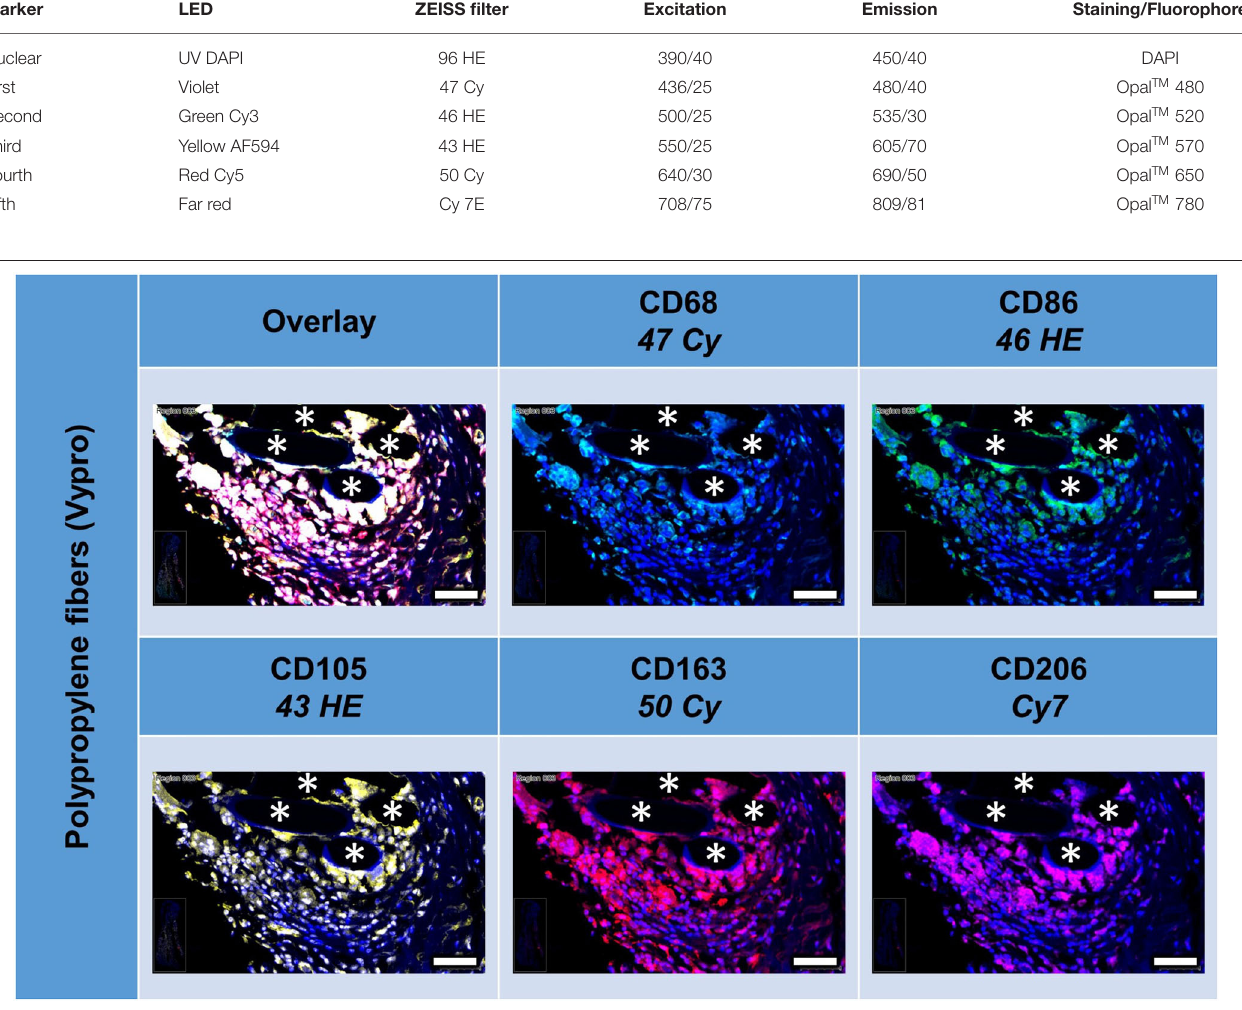
TABLE 2 | List of LED modules, filters with excitation and emission [wavelength/FWHM], and staining/fluorophore. Marker